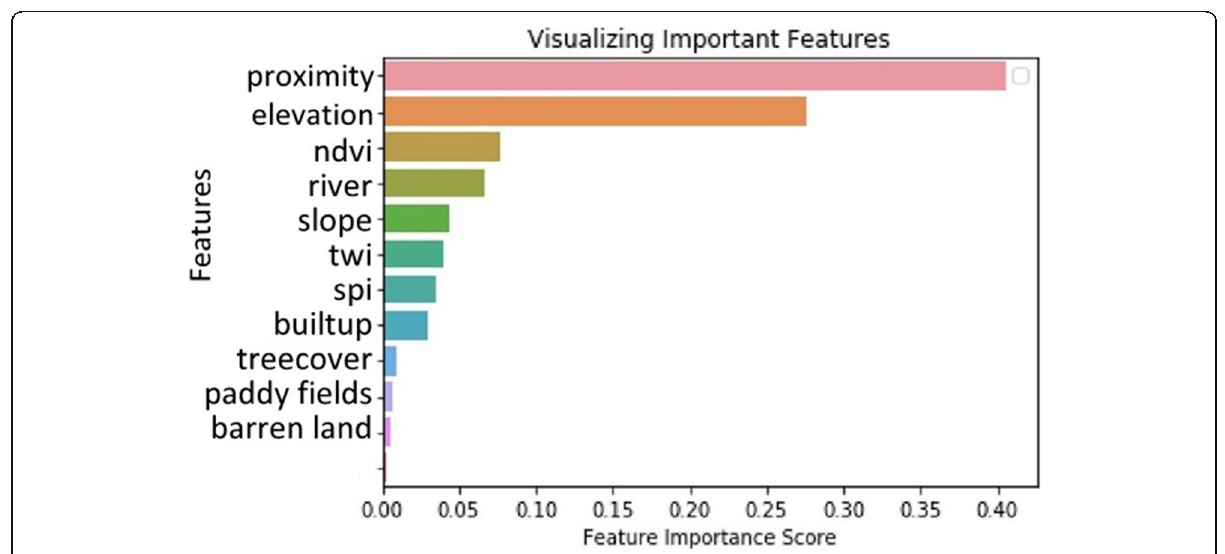
Fig. 12 Degree of Importance of Features and their